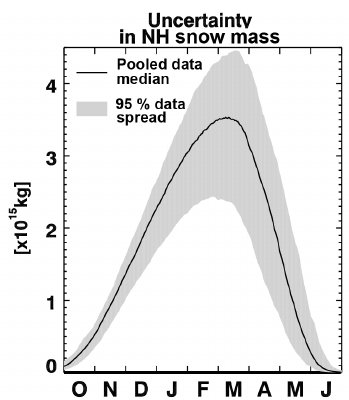
Figure 9. Daily median and spread (5th–95th percentile) among the five snow products listed above for the 1981–2010